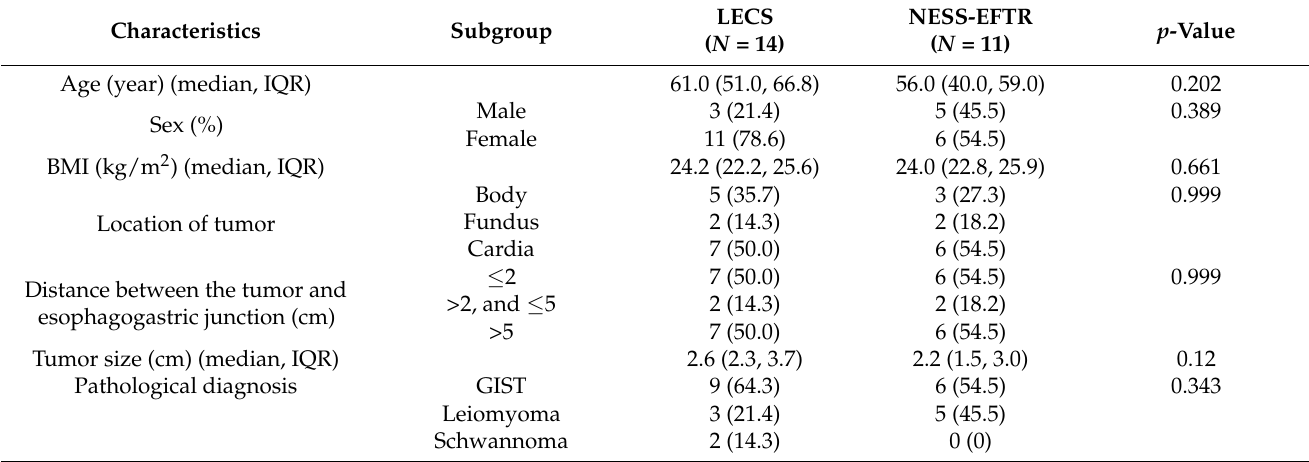
Table 1. Baseline